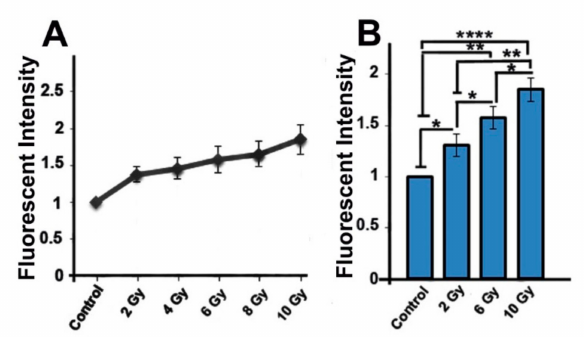
Figure 2. Quantification of reactive oxygen species (ROS) production in all groups ( A , B ). One-way ANOVA with Tukey test was applied. All values are means ± SD; n = 3. * p < 0.05, * * p < 0.01, **** p < 0.0001.